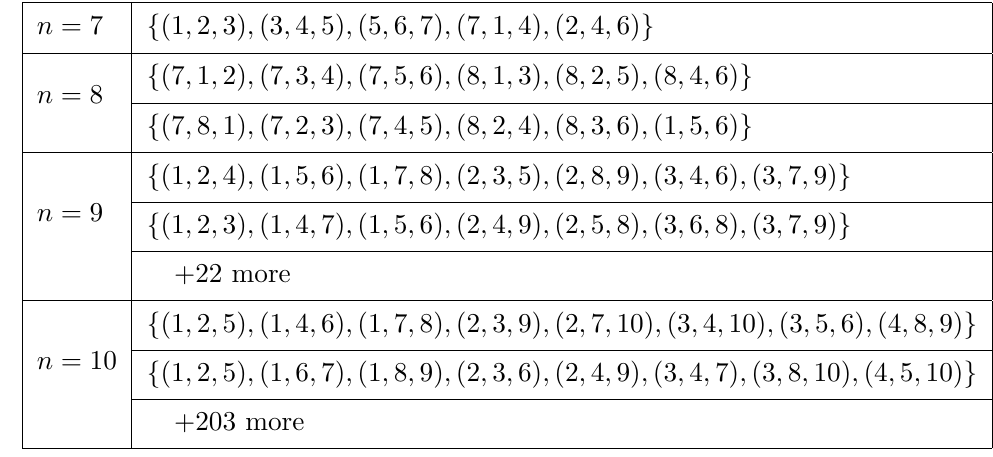
Table 1. All types of IS-irreducible triplet sets up to relabelling for n = 7 and n = 8, and some examples of IS-irreducible triplet sets for n = 9 ; 10.